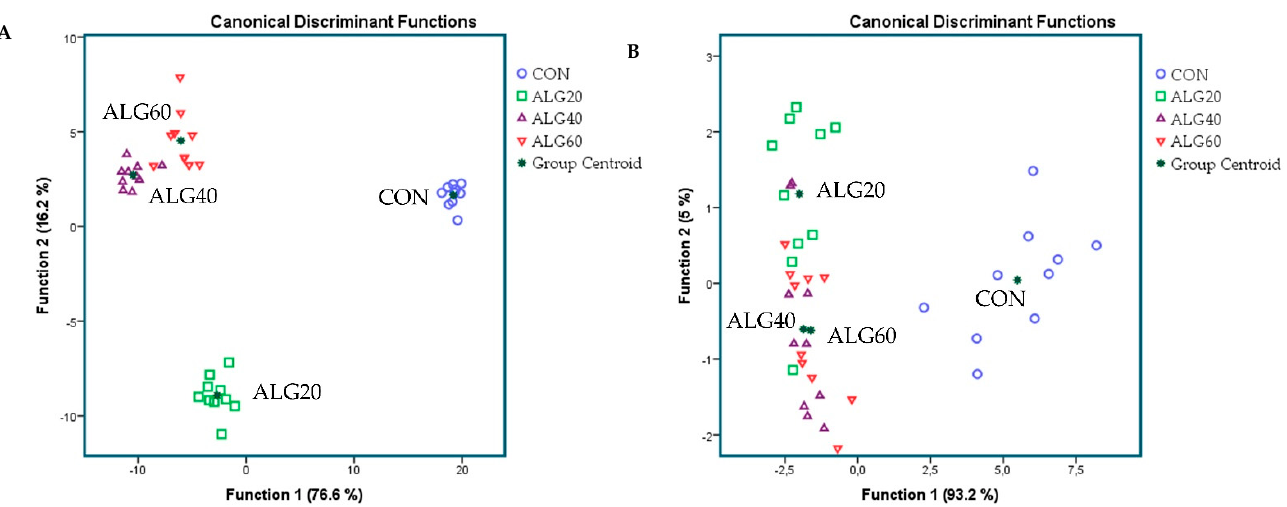
Figure 1. Discriminant plots separating ( A ) the four dietary treatments (CON; blue ○ , ALG20; green □ , ALG40; purple △ , and ALG60; red ▽ ) according to pooled data of two sampling times (20th and 40th experimental day) that entered independents together on the abundances explained the forty-three most abundant genera in goats’ rumen (> 0.06%) and ( B ) discriminating the four dietary treatments (CON; blue ○ , ALG20; green □ , ALG40; purple △ , and ALG60; red ▽ ) based on a step-wise method. CON = control concentrate without microalgae ( Schizochytrium spp.); ALG20 = CON with 20 g/Kg Schizochytrium spp.; ALG40 = CON with 40 g/Kg Schizochytrium spp.; ALG60 = CON with 60 g/Kg Schizochytrium spp.